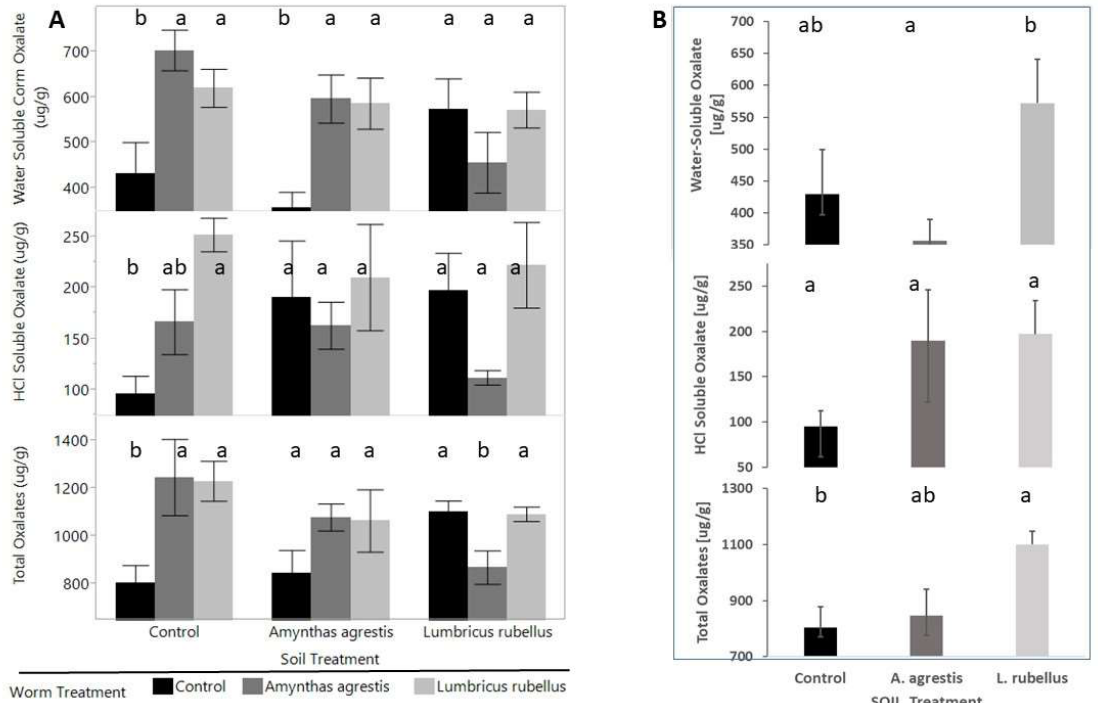
Figure 5. ( A ) Comparisons between SOIL treatment without any worms added, showing some effect of SOIL in the total and water-soluble oxalates. Different letters indicate significant differences at the p = 0.10 level. ( B ) Water- and HCl-extractable oxalate and total oxalates as a function of earthworm and soil treatment. Error bars specify one standard error. Different letters indicate significant differences at the p = 0.05 level for comparisons of WORM treatments within a SOIL pretreatment.